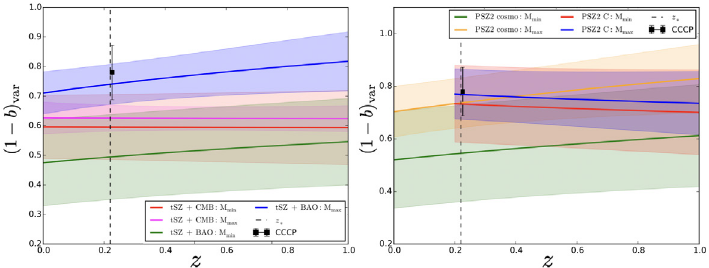
Figure 3. Two-dimensional probability distributions in ( Ω m σ 8 ) parameter plane for the Euclid-like, LSST-like and WFIRST-like experiments. These plots are taken from